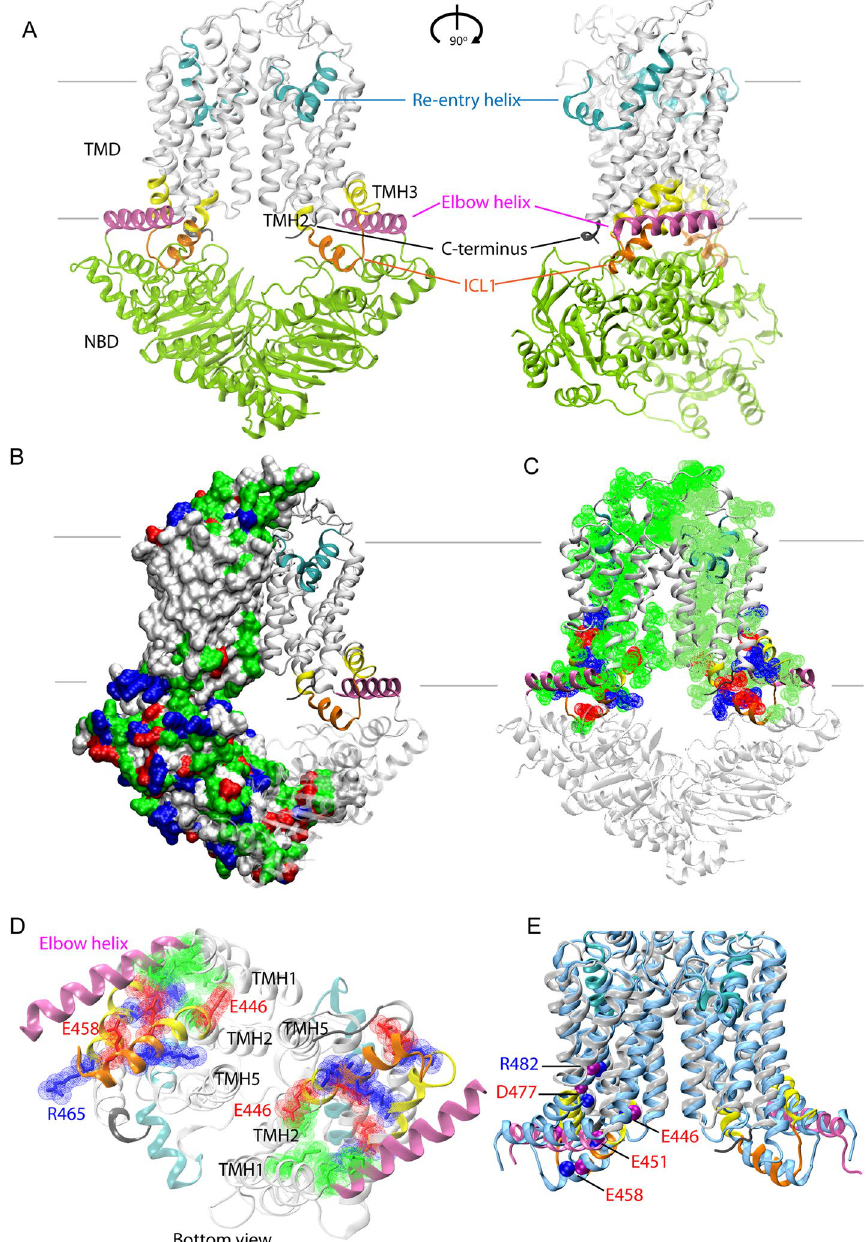
Figure 1. The structural model of ABCG2 reveals a novel configuration of the transmission interface. ( A ) Model of the homodimeric ABCG2 transporter in ATP-free state based on coordinates of ABCG5/G8 PDB ID: 5D07 in two views rotated by 90°. The conformation shows pronounced symmetry, including three distinct structural features forming the transmission interface in each monomer, including the elbow helix (pink), the first intracellular loop ICL1 (orange), and the surface of the NBD dimer (green); the extracellular re-entry helix (cyan) is protruding into the outer leaflet; cytoplasmic distal helical parts of TMH2 and TMH3 (yellow); C-terminus (black); TMHs (light grey), TMD, transmembrane domain, NBD, nucleotide binding domain. ( B ) Polar residues on the ABCG2 surface. The ABCG2 monomer based on ABCG5 shows residues as surface potential filling; positive charges (blue), negative charges (red), polar (green), non-polar (white). The second half is based on ABCG8 using the same color-coding of domains as above. ( C ) Polar residues in the TMD of ABCG2 molecule. ( D ) Inside-outside bottom view of ABCG2 TMDs with the NBDs removed for better overview. ( E ) Superimposition of TMDs in the cryo-EM structure 40 of ABCG2 (PDB ID: 5Nj3) (blue) and the atomic model obtained in this study using a ribbon representation limited to the TMD regions. Color code as in panel A. Blue balls indicate residue positions, whereas purple balls indicate residues in the present atomic model. The ABCG2 cryo-EM structure PDB ID: 5Nj3 corresponds to a ABCG5 homodimer, while the present atomic model is based on the ABCG5/G8 heterodimer PDB ID: